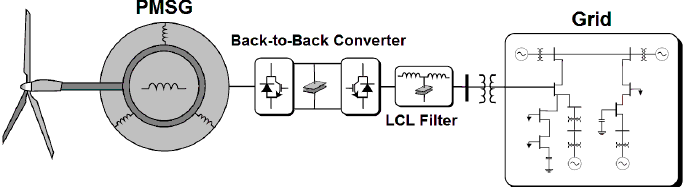
Figure 2. Wind conversion system using the permanent magnet synchronous generator (PMSG) with full scale converter.